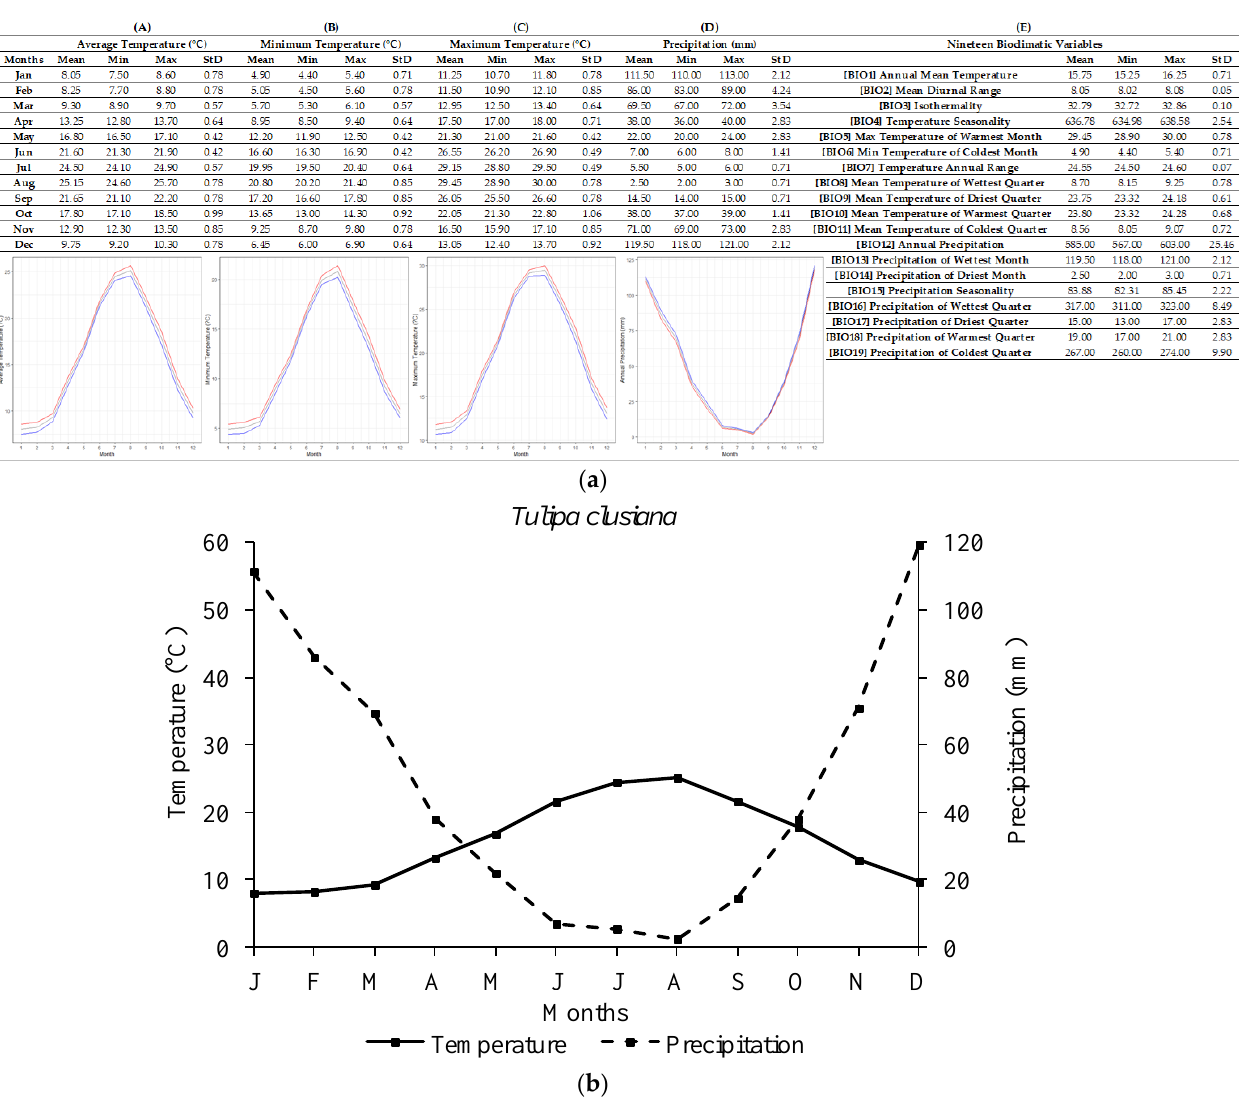
Figure 4. R-derived ecological profile ( a ) and Walter–Lieth climate diagram ( b ) of Tulipa clusiana based on two Greek localities known to date ( n = 2). For ( A – E ), minimum, maximum, and average values and standard deviations are represented in different columns. Line graphs ( A – C ) illustrate the minimum (blue), the maximum (red), and the mean (grey) monthly temperature ( ◦ C) and the line graph ( D ) illustrates the minimum (red), maximum (blue), and mean (grey) monthly precipitation (mm). ( A ) shows the minimum temperature in each month ( ◦ C), ( B ) shows the maximum temperature in each month ( ◦ C), ( C ) shows the average temperatures per month ( ◦ C), ( D ) shows the precipitation in each month (mm), and ( E ) shows the values for each of the 19 bioclimatic